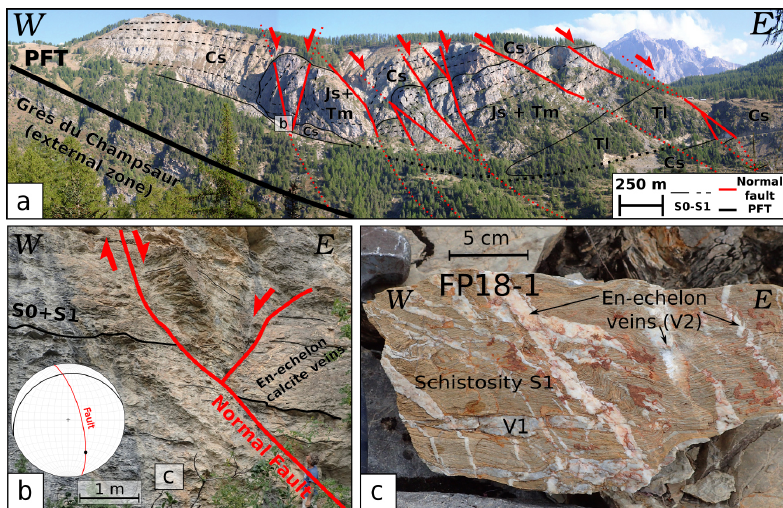
Figure 3. (a) General view and geological interpretation of the Fournel Valley southern slope with the studied site of the Tête d’Oréac. (b) Outcrop interpretation of the Tête d’Oréac with extensional features in Late Cretaceous calcschists in agreement with the High Durance fault system and Wulff stereogram, lower hemisphere. (c) Calcschist-oriented sample FP18-1 evidencing multiple calcite vein generations. V1 is related to the main compressional phase related to the Tête d’Oréac anticline formation, and V2 are related to extensional reactivation of the PFT during onset of the High Durance fault system. Cs: Late Cretaceous calcschists; Js + Tm: Middle Triassic–Late Jurassic dolomitic– siliceous limestones; Tl: Lower Triassic